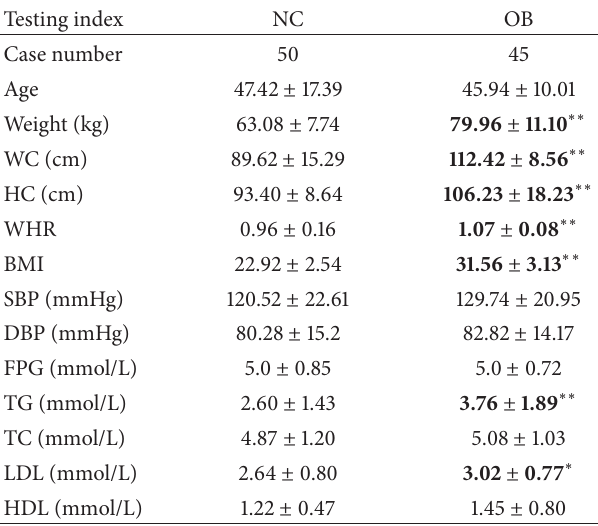
Table 2: Comparison of subject metrics and biochemical parame- ters between NC and OB